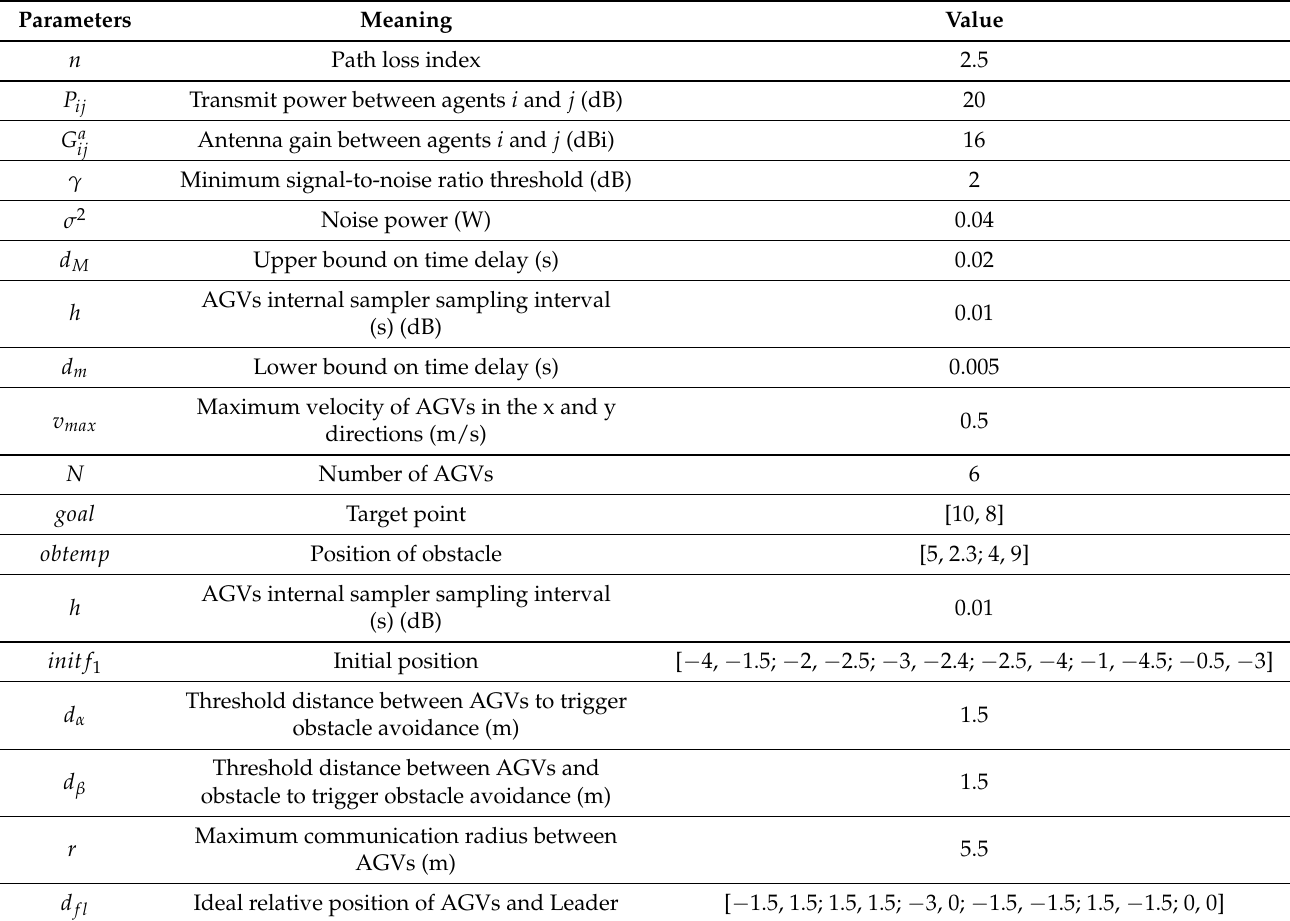
Table 1. The simulation